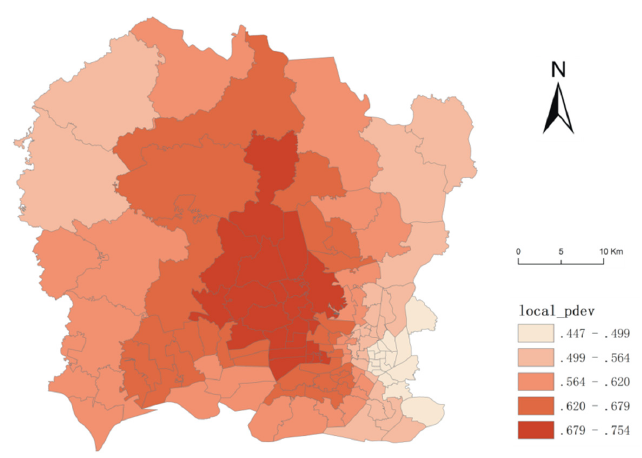
Figure 3. Goodness-of-fit (Local_pdev) of GWPR model.